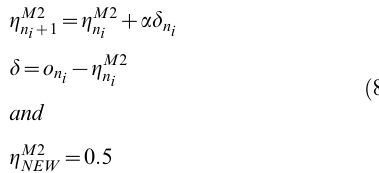
sequence of face cues and outcomes presented to our subjects (i.e. the sequence of blue/purple choices made by each